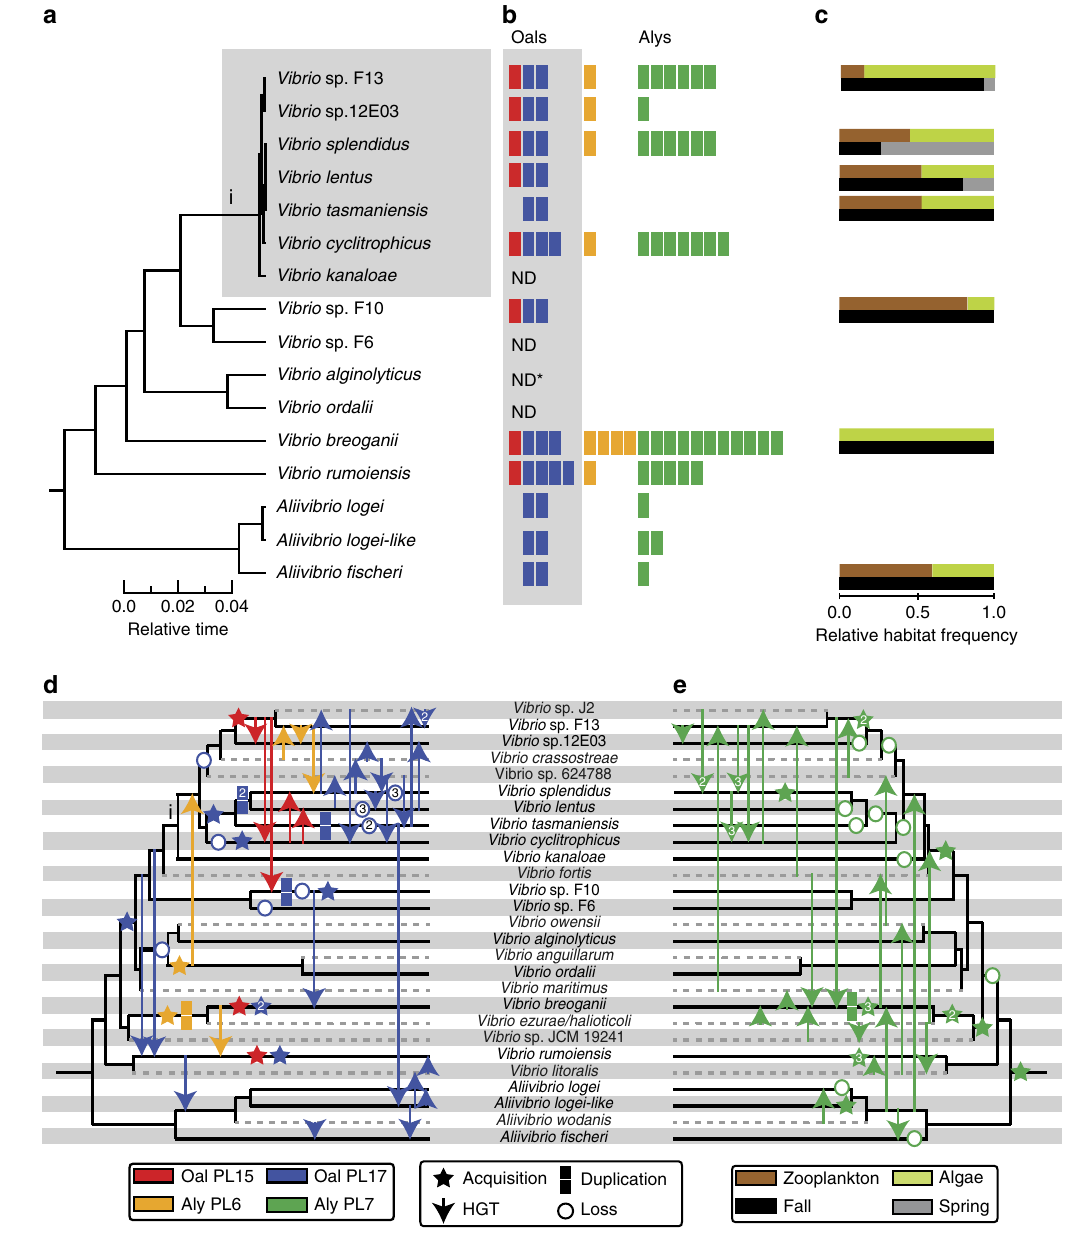
Figure 1 | Evolutionary history and ecological occurrence of alginate lyases. ( a ) Relative timed maximum-likelihood phylogeny of Vibrionaceae populations co-occurring in the same water samples. Species names are assigned if a previously described type strain falls within the population; otherwise, the designation Vibrio sp. is given. ( b ) Maximum copy number of alginate lyase families within members of a population identified by presence of a single enzymatic domain are represented by coloured rectangles. ND indicates that Alys and Olys were not detected. ND* indicates that while no Alys or Olys were detected in V. alginolyticus isolates from our collection, it is present in other V. alginolyticus isolates from geographically distant locations (Supplementary Fig. 1). ( c ) Normalized distribution of isolates obtained from algal detritus particles and zooplankton handpicked under a dissecting microscope and phylogenetically categorized by multilocus gene analysis for two seasonal samples. ( d , e ) Phylogenetic reconciliation (Methods) by comparison of pathway-specific gene trees (Supplementary Figs 6–9) and a timed ‘species’ tree showing the history of each of four lyase gene families embedded in the reference species phylogeny: ( d ) Oal domains PL15 and PL17, and Aly domain PL6; ( e ) Aly domain PL7. Acquisition represents an independent entry of a subfamily into a clade within our collection. Solid and dashed lines on the phylogenetic tree indicate clades represented in our collection or obtained from Genbank, respectively. Numbers within symbols indicate multiple independent occurrences of the represented event. Within- population HGT and duplication are not depicted. Lowercase Roman numeral i indicates the crown group consisting of seven closely related